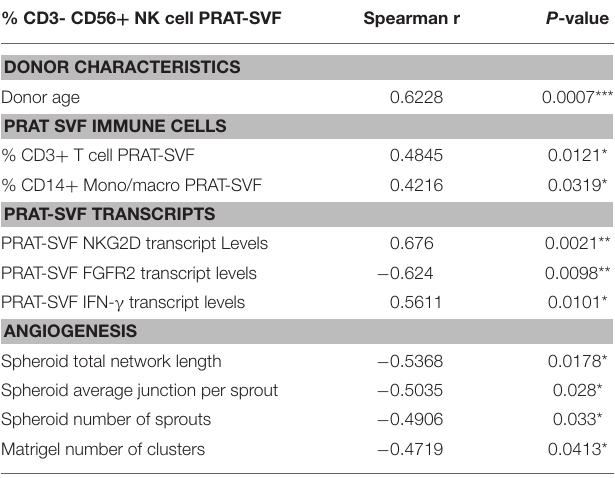
TABLE 2 | Analysis of the link between quantitative parameters evaluated in PRAT-SVF and % of PRAT-SVF NK cells.